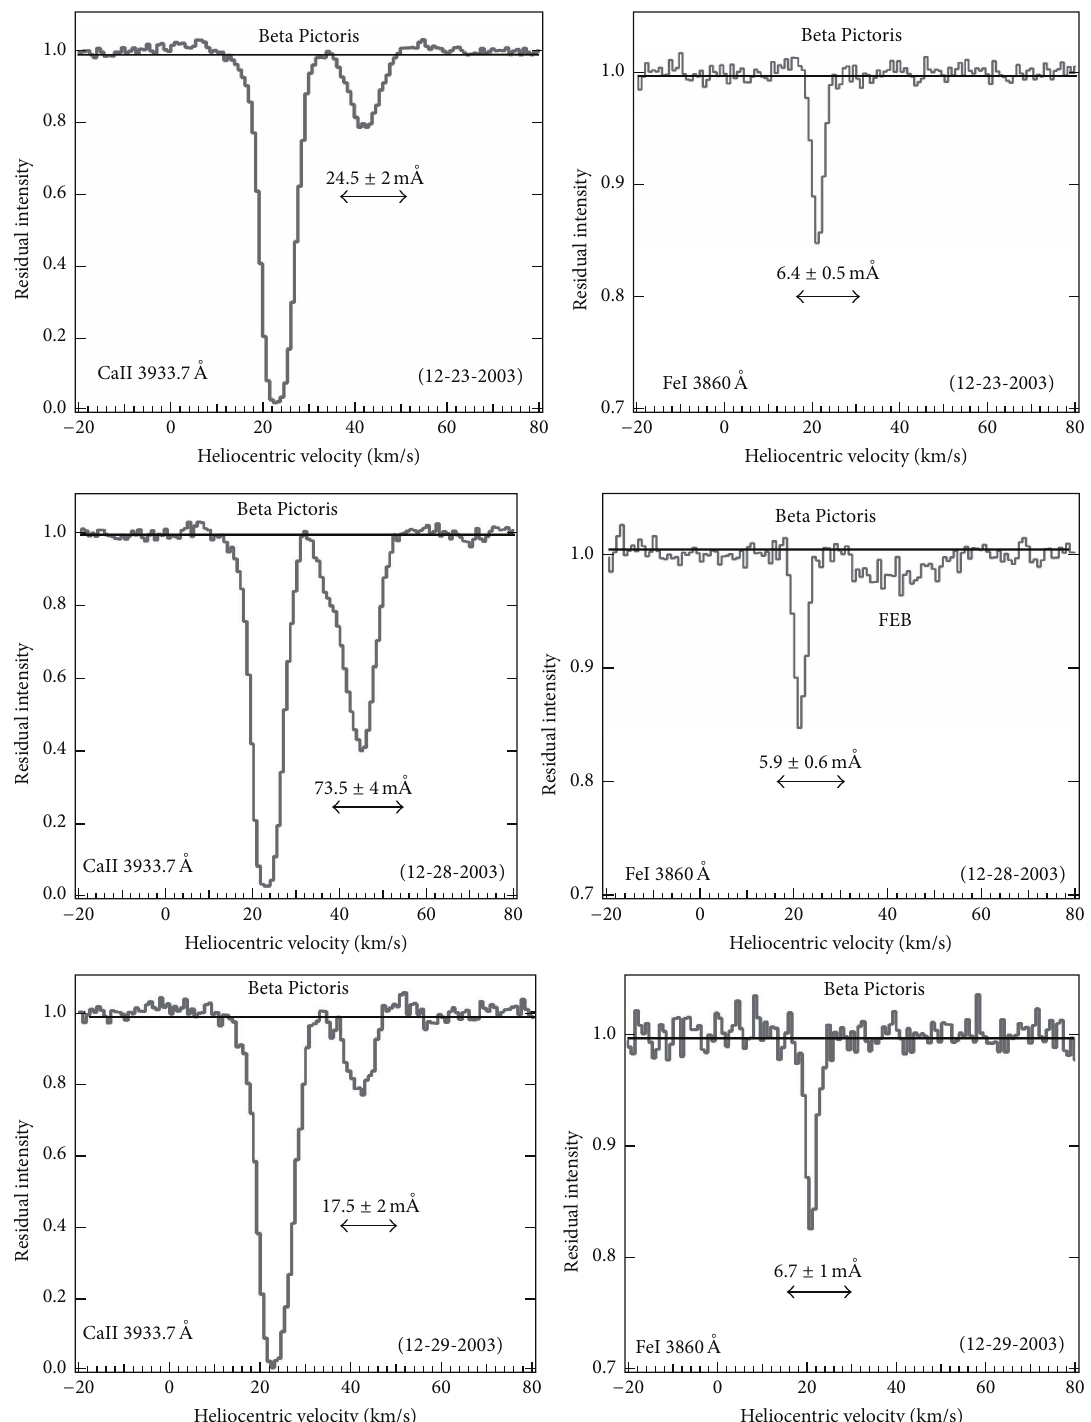
Figure 8: Circumstellar CaII K-line and FeI 3860 ˚A absorption lines recorded towards 𝛽 Pictoris over a 6-day timeframe in 2003. Note the appearance of an FEB event at 𝑉 ∼ +45 kms −1 in the FeI spectrum of